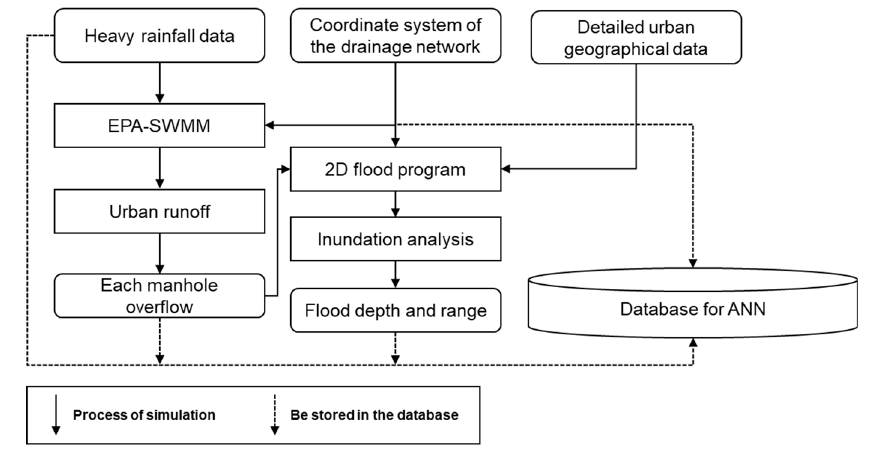
Figure 2. Flowchart for building a database for predictive modeling.